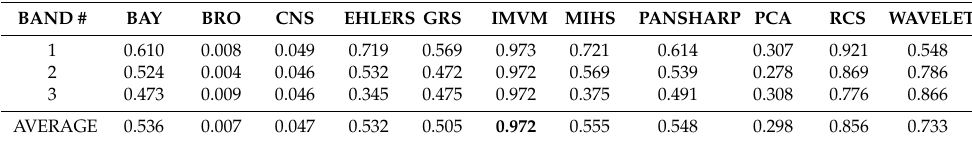
Table 4. Spectral consistency: universal image quality index (UIQI).